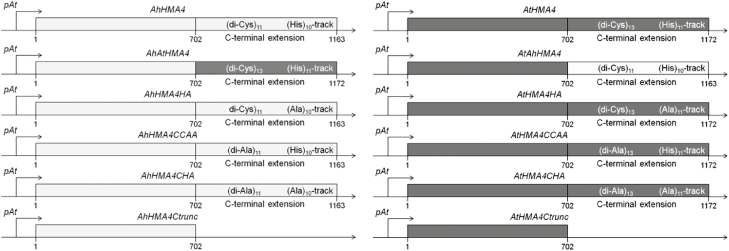
Overview of the HMA4 variant constructs for complementation experiments in plants. The expression cassettes are schematically represented. The nucleotide sequences encoding A. thaliana (dark gray) or A. halleri (light gray) native or mutant HMA4 proteins are preceded by the A. thaliana HMA4 promoter (pAt, 2595 bp). Numbers correspond to the amino acid position in the HMA4 protein. Ah, A. halleri; At, A. thaliana; AtAhHMA4 and AhAtHMA4, swapped C-terminal extensions; HA: His- → Ala-stretch; CCAA: di-Cys → di-Ala motifs; CHA: HA and CCAA mutations combined; Ctrunc: fully truncated C-terminal extension.